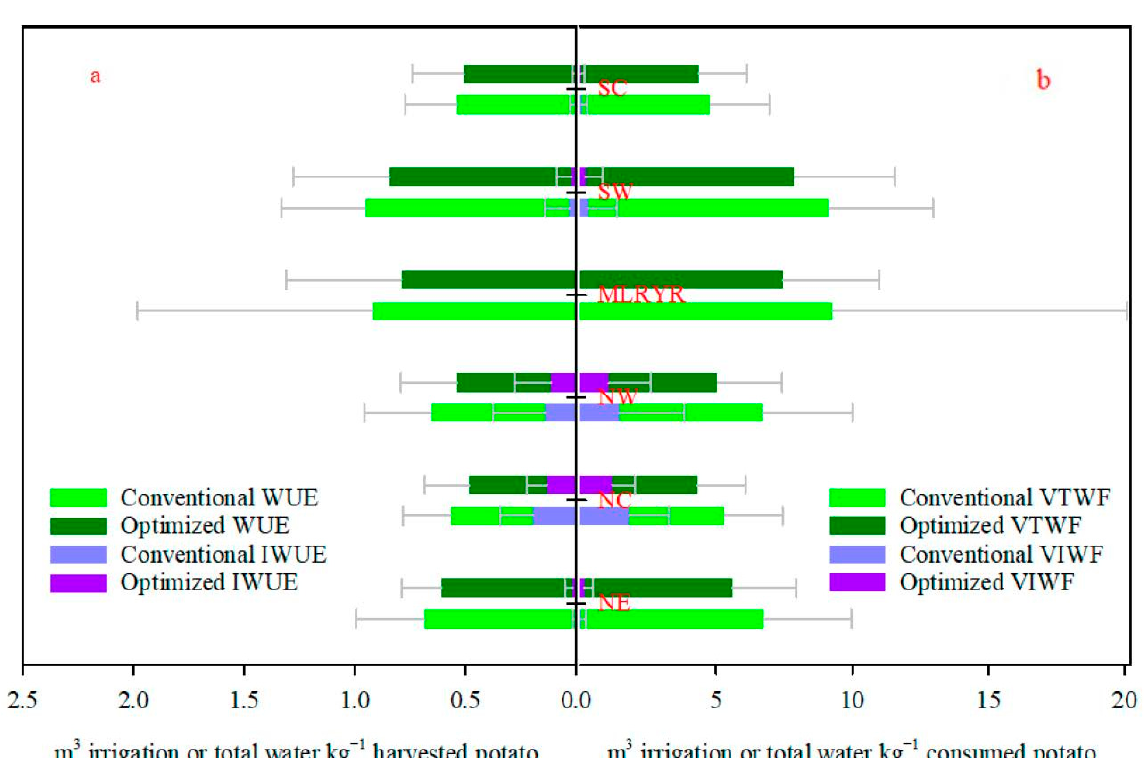
Figure 4. IWUE and WUE ( a ), VIWF and VTWF ( b ) indicators of potato under conventional and optimized measures in the six cultivation regions. In NE, MLRYR, SW, and SC regions, there is almost no irrigation; potatoes are grown under rainfed conditions.